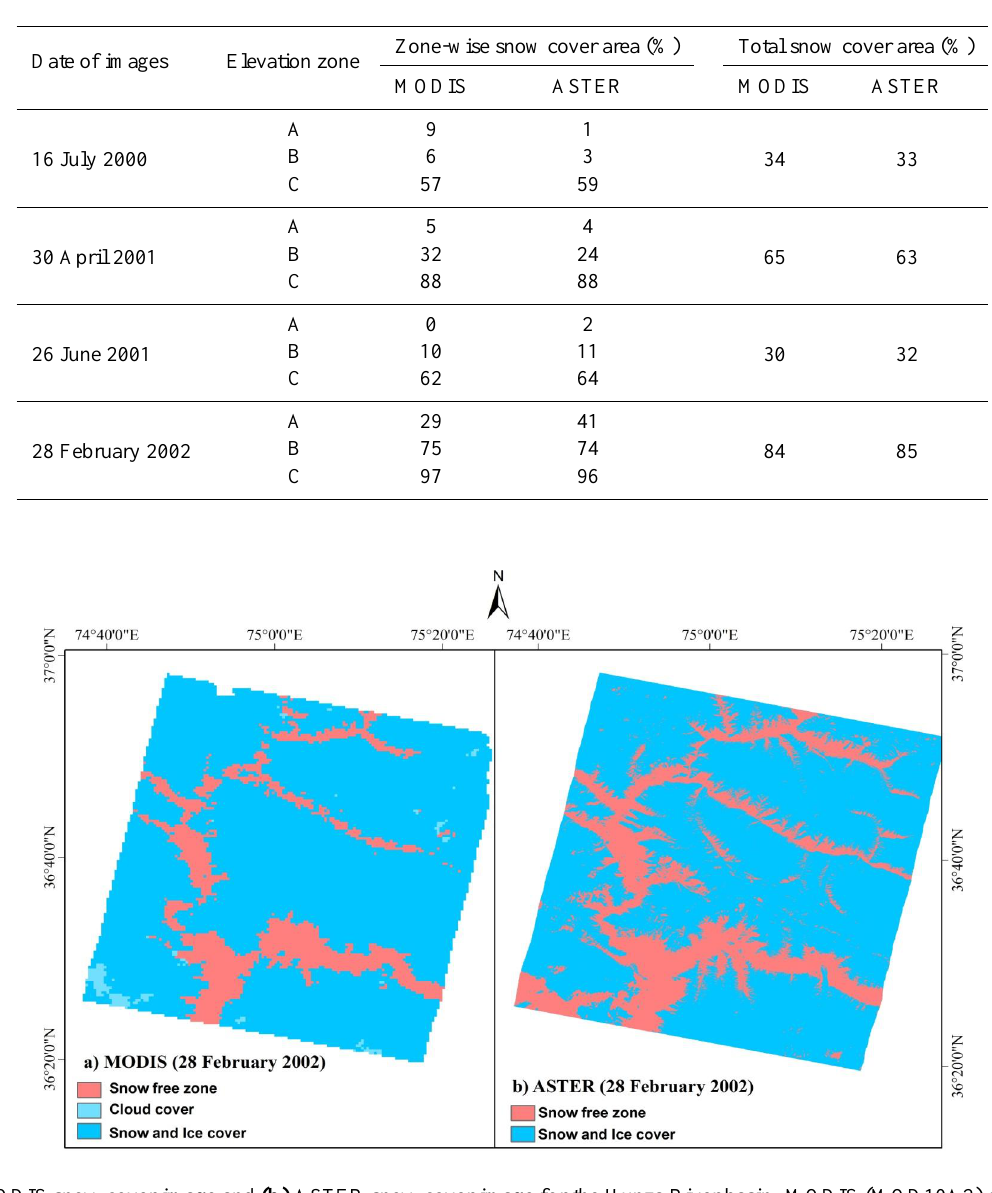
Table 4. Comparison of zone-wise and total snow cover area on MODIS and ASTER images for validation of MODIS images. (The main characteristics of the elevational zones are given in Table 2).